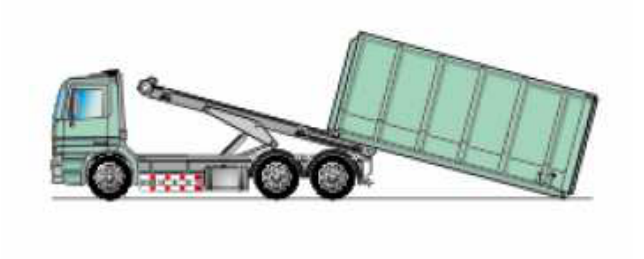
Figure 3. Detachable swap body